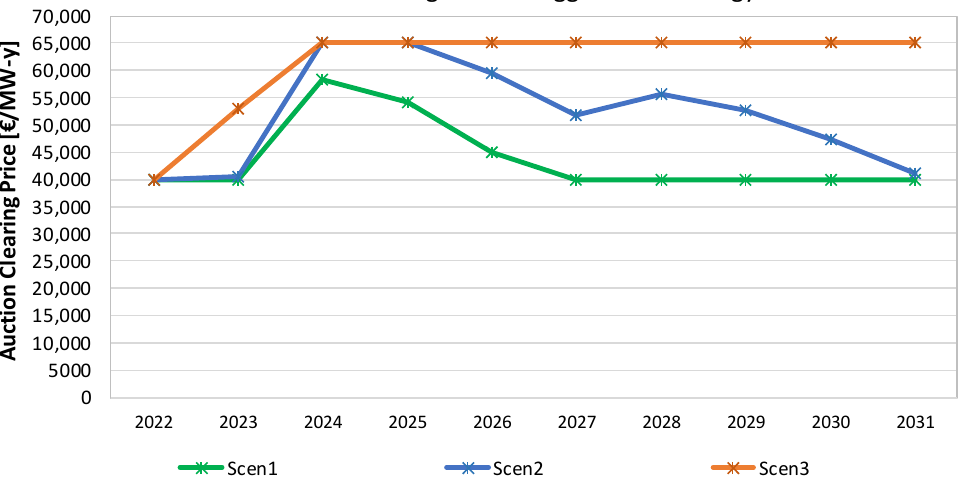
Figure 8. Auction clearing prices–Aggressive strategy.